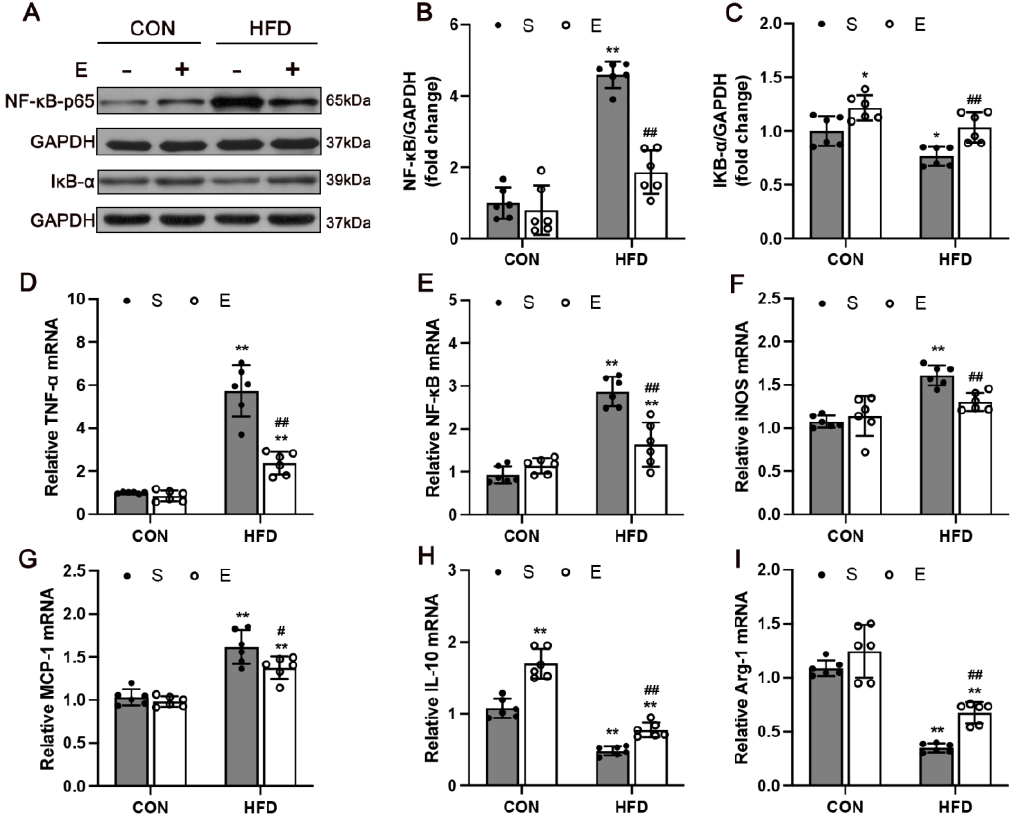
Figure 6. Aerobic exercise ameliorates skeletal muscle inflammation in HFD-fed mice. ( A ) Western blot images and quantifications of muscle samples, including: ( B ) NF-κB and ( C ) IκB-α, n = 6. ( D ) mRNA expression of TNF-α, NF-κB ( E ), iNOS ( F ), MCP-1 ( G ), IL-10 ( H ), Arg-1 ( I ) in skeletal muscle. Values are expressed as the mean ± SD. CON, normal control; HFD, high-fat diet; S, sedentary; E, exercise. * p < 0.05, ** p < 0.01 vs. NS group; # p < 0.05, ## p < 0.01 HS group. n = 6 .